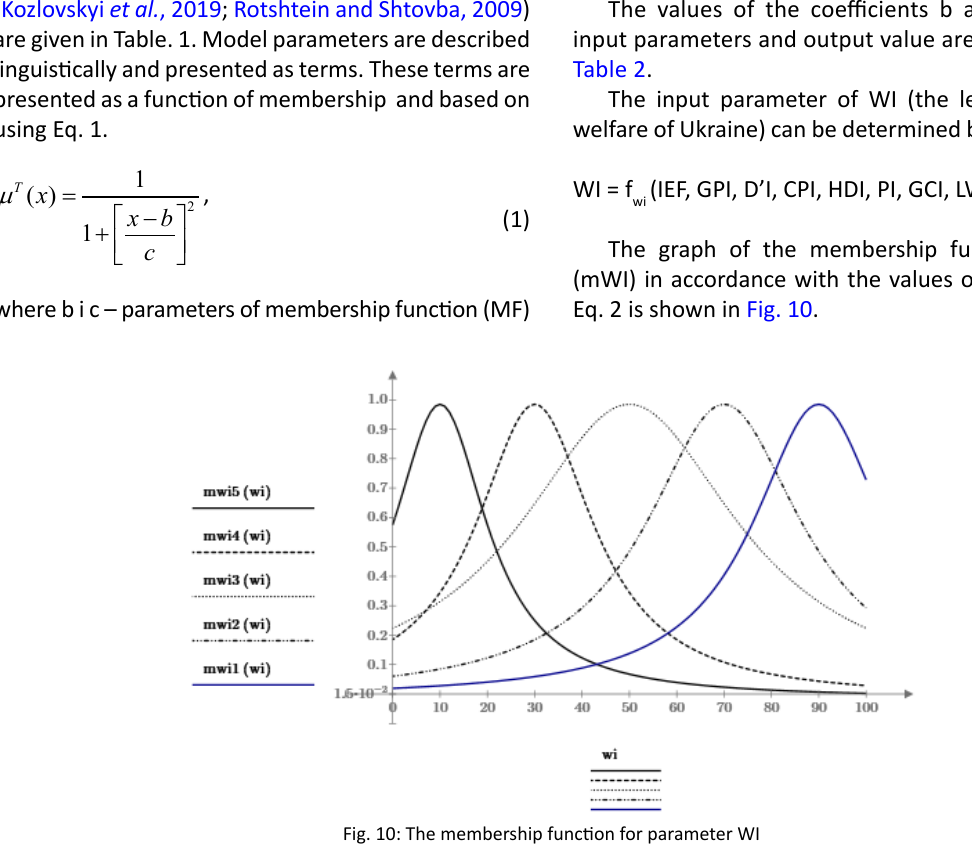
The values of the coefficients b and c for the input parameters and output value are also given in The input parameter of WI (the level of public welfare of Ukraine) can be determined by using Eq. 2.